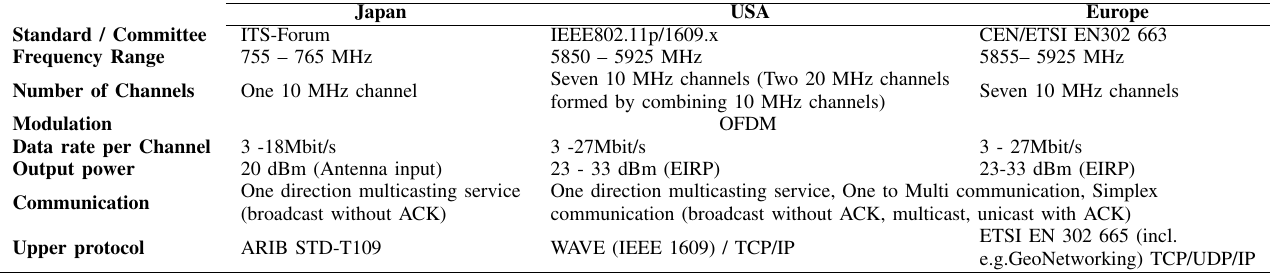
TABLE II O VERVIEW OF ITS FOR THE MAIN RESEARCH STUDIES IN DIFFERENT COMMUNITIES [51].